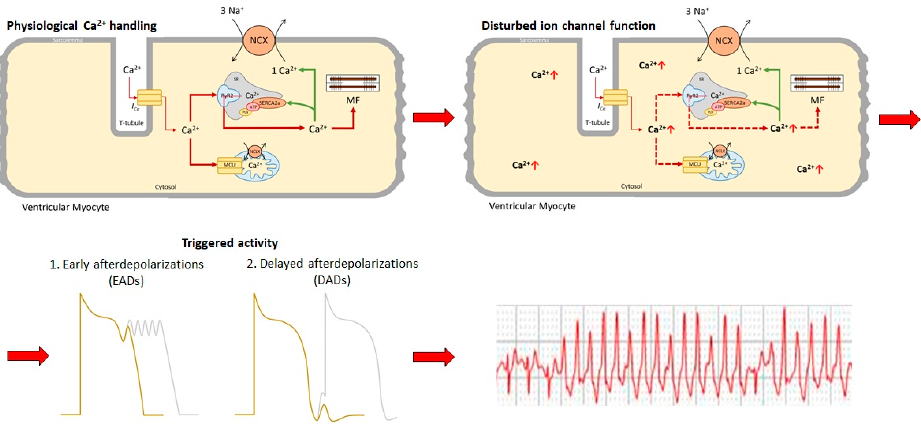
Figure 1. Calcium handling in cardiomyocytes illustrating the most important calcium-related organelles and channels. Disturbed ion channel functions or calcium mishandling results in an increased cytosolic calcium concentration. This further promotes the generation of early and delayed afterdepolarizations, leading to Ca 2 + -induced ventricular tachycardia. Ca 2 + : calcium; I Ca : calcium current; MCU: mitochondrial calcium uniporter; MF: myofilament; NCLX: mitochondrial potassium-calcium exchanger; NCX: sodium-calcium exchanger; RyR2: ryanodine receptor type 2; VES: ventricular extrasystoles; VT: ventricular tachycardia.